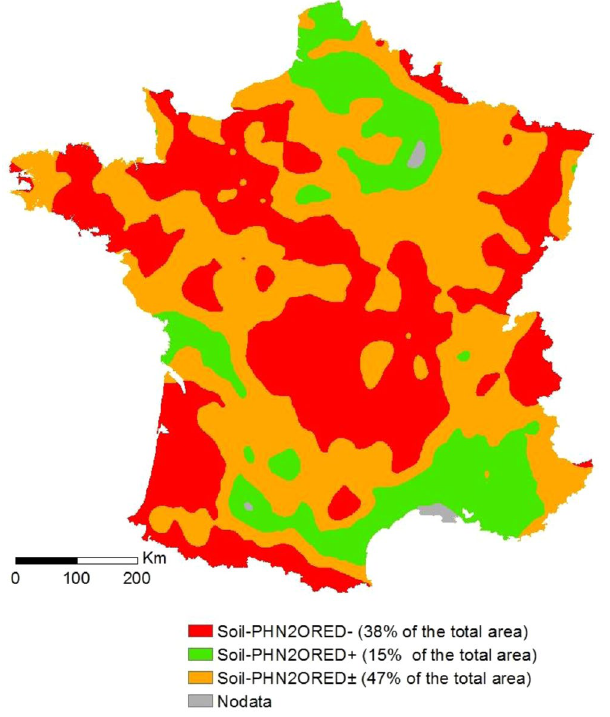
Figure 5. Map of soil N 2 O reduction phenotypes in France obtained from the RMQS